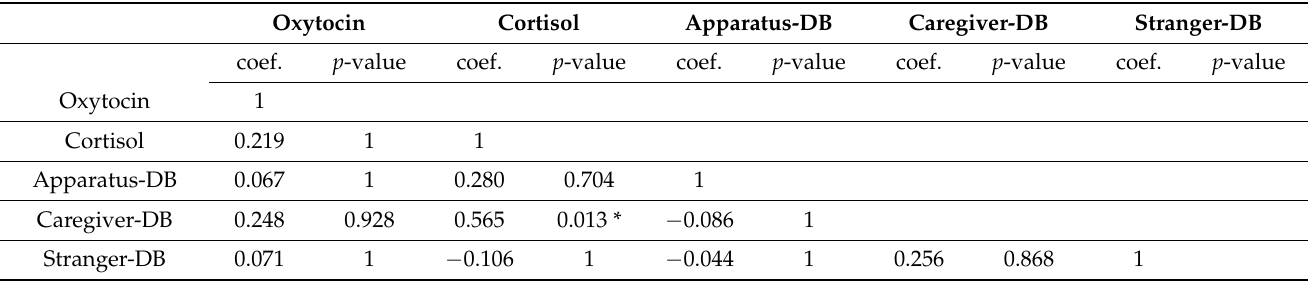
Table 4. Spearman correlations between oxytocin, cortisol, and behavioral variables (latency). Aster- isks indicate a significant correlation. Sample size: 25